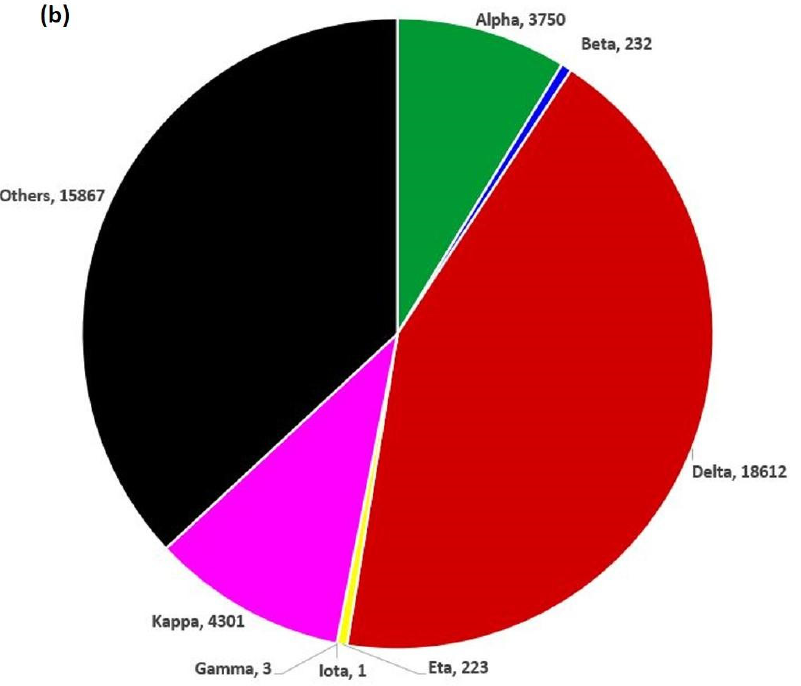
Figure 1. ( a ): Map of India depicting distribution of SARS-CoV-2 genomes sequenced from cases (shown in brackets) reported from the States and Union Territories (UTs) during January 2020 to July 2021. Two letter codes are used to label States and UTs. The number following the State/UT labels indicates the number of sequenced genomes. Note: States/UTs and their codes are as follows. Andaman and Nicobar Islands: AN; Andhra Pradesh: AP; Arunachal Pradesh: AR; Assam: AS; Bihar: BR; Chhattisgarh: CG; Chandigarh: CH; Dadra and Nagar Haveli and Daman and Diu: DNHDD; Punjab: PB; Puducherry: PY; Rajasthan: RJ; Sikkim: SK; Tamil Nadu: TN; Tripura: TR; Telangana: TS; Uttarakhand: UK; Uttar Pradesh: UP; West Bengal: WB. Cases from DNHDD are as of 23 October 2021 and therefore marked with *. ( b ): Prevalence of WHO designated variants of concern (VoC) and variants of interest (VoI) based on pan-India genome sequencing coverage. The frequency distribution of isolates with respect to lineage data, geographic locations (States and UTs), and time of isolation is shown as Figure 2a–c. These plots indicate that the state of Maharashtra sequenced isolates since the onset of the pandemic (January 2020). The states West Bengal, Gujarat, Karnataka, Telangana, and Uttar Pradesh in addition to UTs of Delhi, Jammu, Kashmir, and Chandigarh have good sequencing coverage (starting from February–April 2020 until 15 August 2021) as compared to the rest of the country. Figure 2 also shows the presence of lineages Alpha, Beta, Delta, Eta, Iota, Gamma, and Kappa in addition to all Others (which includes lineages that are not designated as VoI and VoC) in most of the States/UTs during the pandemic with varying